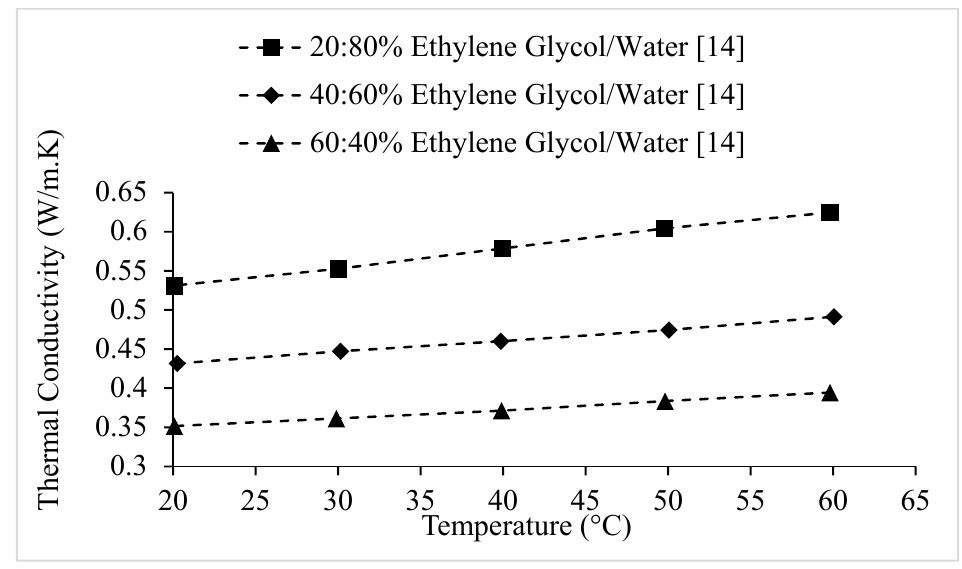
Figure 14. Variation of nanodiamond nanofluid thermal conductivity as a function of temperature, for different weight concentrations of Ethylene Glycol/water base liquid, at 𝜑 = 1% .